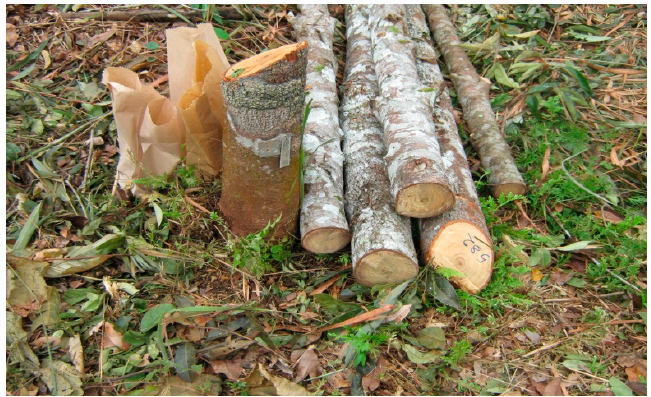
Figure A12. A rosewood tree cut at 50 cm from the ground as required by law in Central Amazonian commercial rosewood plantations.